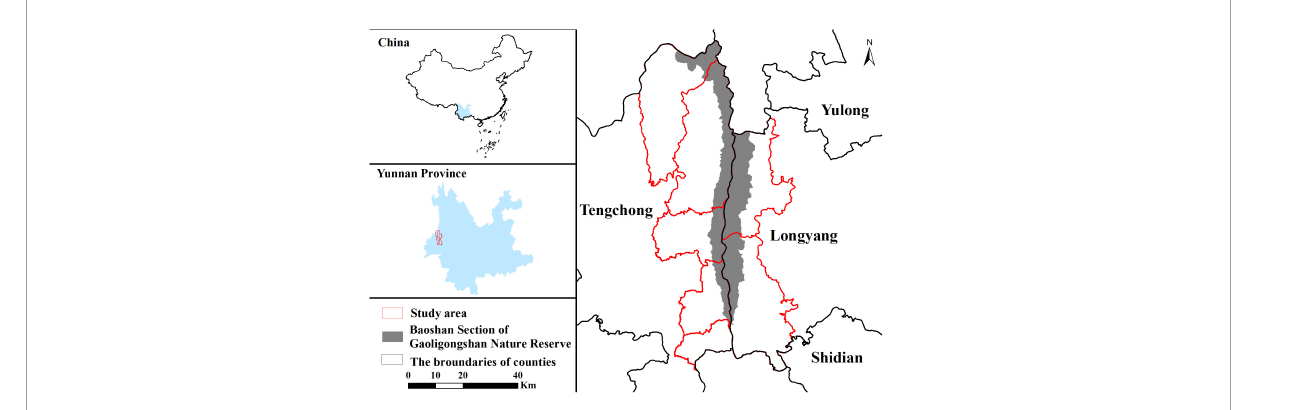
FIGURE1 Map of the study area. The map shows locations of the Baoshan Section of Gaoligongshan Nature Reserve and study